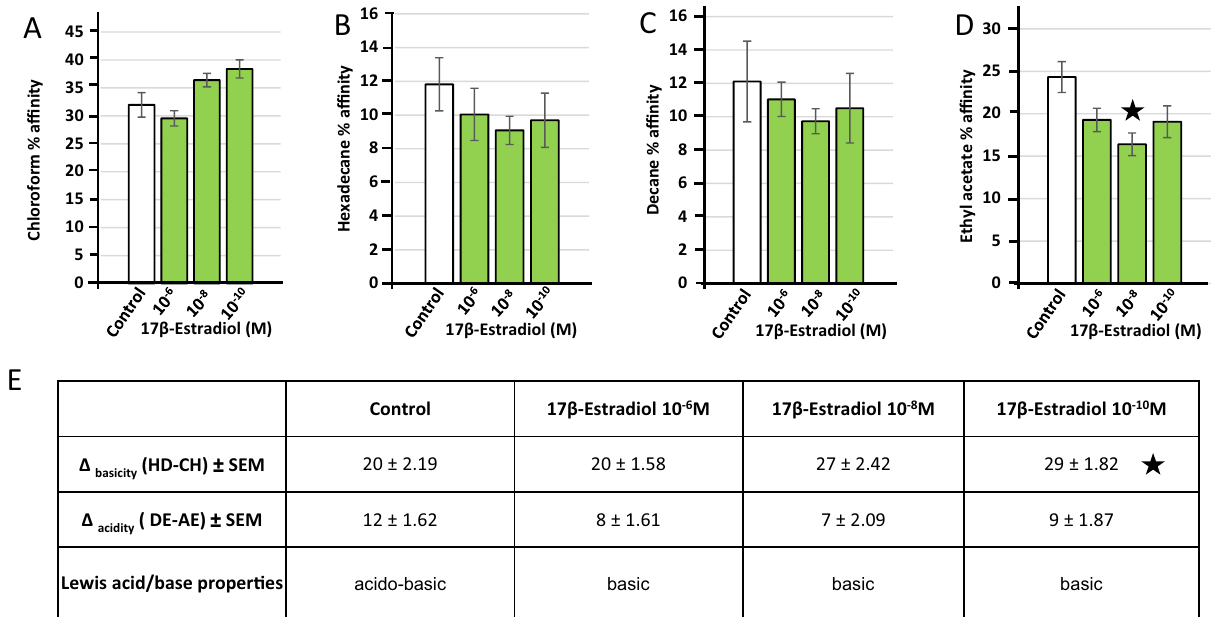
Figure 2. Effect of 17β-estradiol (10 –6 , 10 –8 and 10 –10 M) on the solvent affinities and Lewis acid/base surface properties of Lactobacillus crispatus CIP104459. ( A ) Partitioning between water and chloroform. ( B ) Partitioning between water and hexadecane. ( C ) Partitioning between water and decane. ( D ) Partitioning between water and ethyl acetate. ( E ) Lewis acid/base behavior of L. crispatus CIP104459 with the two solvent couples hexadecane (HD)/chloroform (CH) and decane (DE)/ethyl acetate (EA). The values presented are the means ± SEM of three independent studies. (* = p <